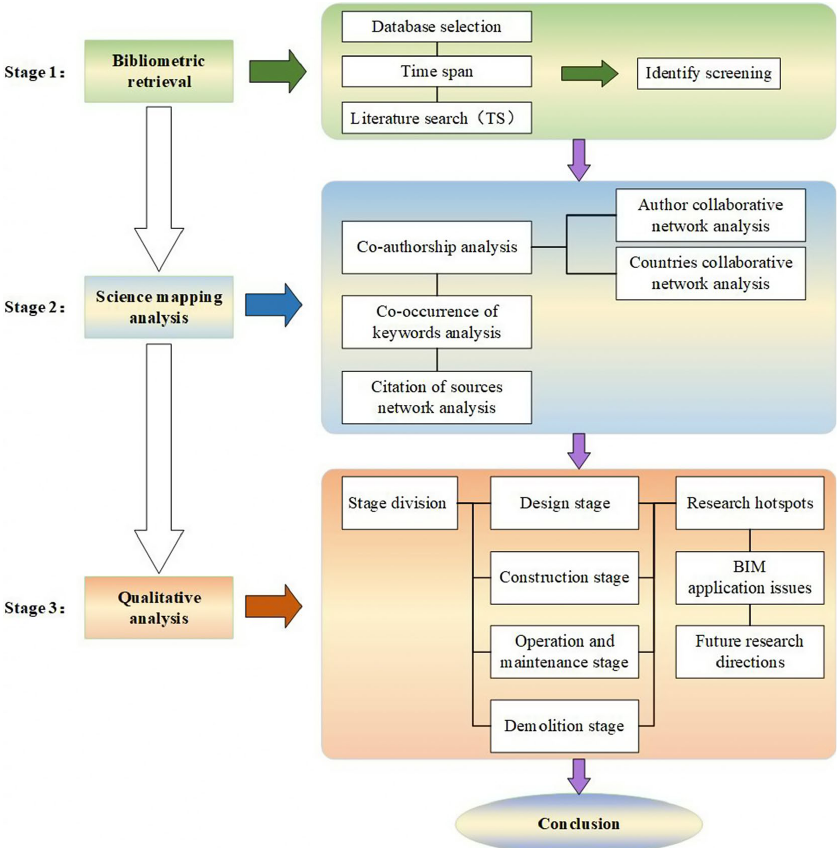
Figure 1. Research framework of this study